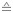
Repeated bursts of MCα2 inhibition synchronize type A PC spike trains via minimally depressing IPSPs.(A) Voltage traces from an unconnected pair of type A PCs (black and grey) with MCsα2 stimulated in 15-Hz bursts at 2 Hz (blue dots). Orange rectangles highlight synchronous APs. (B) Mean cross-correlograms (n = 24 cells) show little synchrony before light stimulation and increased synchrony during light stimulation (15-Hz bursts in 2 Hz) of MCsα2 as shown by a prominent peak around zero (and recurring peaks at every 500 ms). (C) Box plots of the synchrony indices for control and 15-Hz bursts show the significant increase of synchrony (0 ≙ no synchronization, 1 ≙ full synchronization) when MCsα2 are stimulated by blue light in brief bursts (n = 12 dual recordings, p < 0.0001, two-tailed Student’s paired t test). Values are shown in S8 Data. (D) IPSPs in type A PCs (n = 24 cells, single examples in grey, mean in black) following burst protocol of 15-Hz stimulation in 2 Hz (top) and constant 15-Hz light stimulation (bottom). Note minimal-depressing inhibition in the top and the depression of IPSPs leading to a rapid diminution of inhibition in the bottom (red dashed lines for improved visualization).